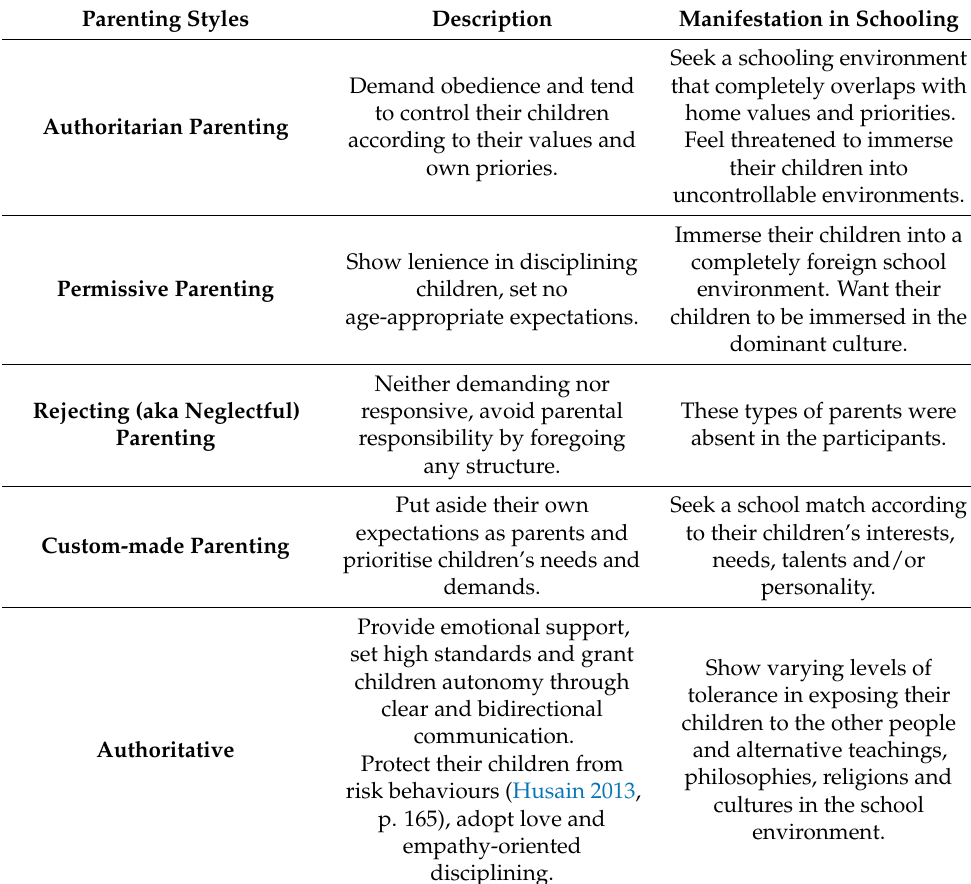
Table 4. Manifestation of Parenting Styles in